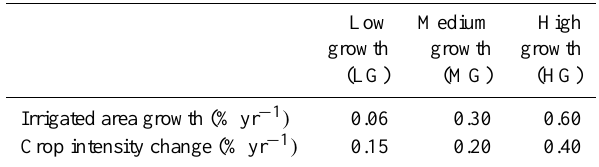
Table 7. Scenarios for industrial water intensity change (m 3 yr − 2 MWh − 1 )